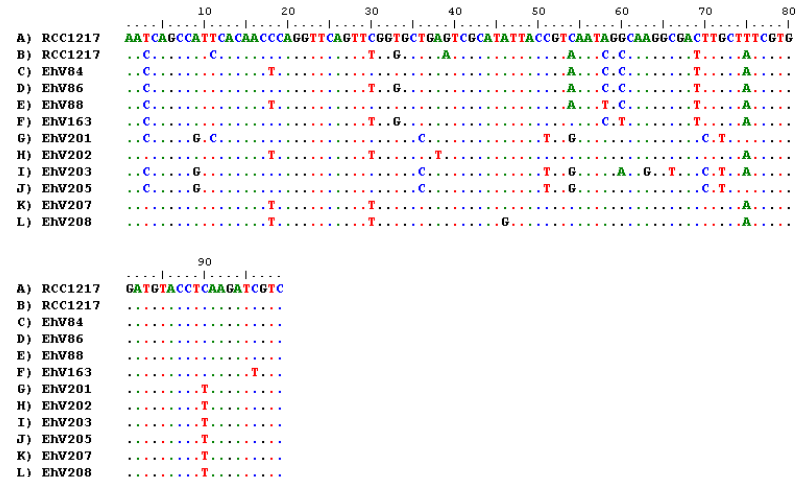
Viruses 2017 , 9 , 51 13 of 18